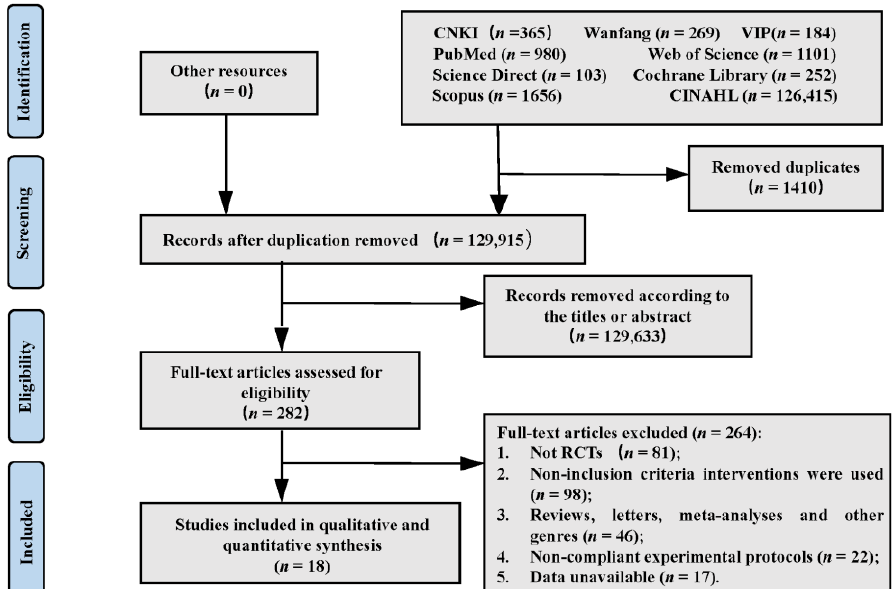
Figure 1. Characteristics of Included Studies.